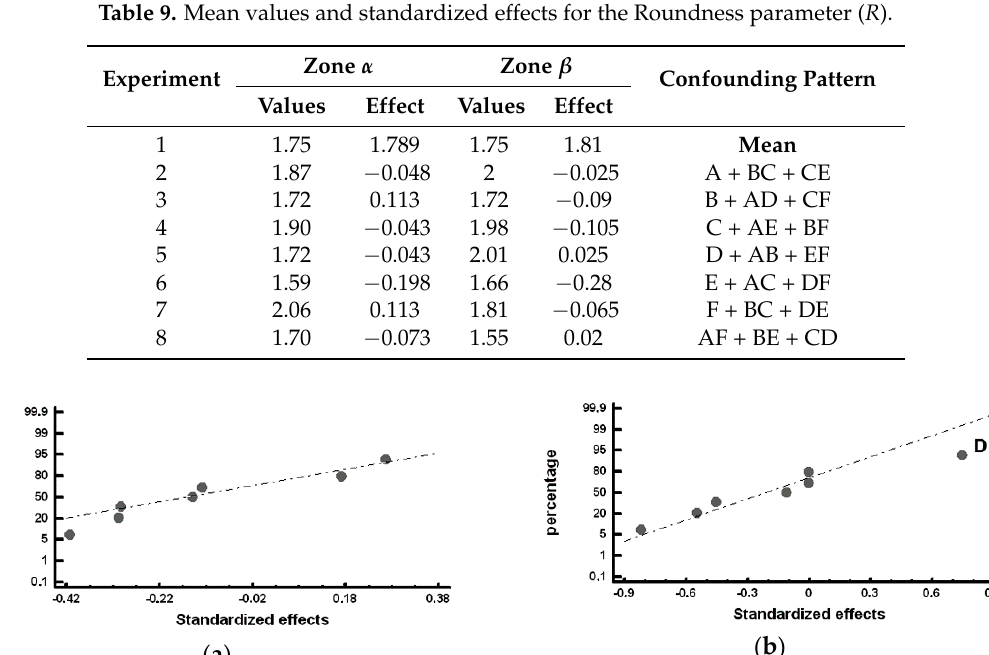
Figure 2. Standardized effects on the volume fraction of graphite on a normal probability plot: ( a ) Factors with a significant effect on the outermost region of the working layer (Zone α ); ( b ) Factors with a significant effect on the inner region of the working layer (Zone β ).